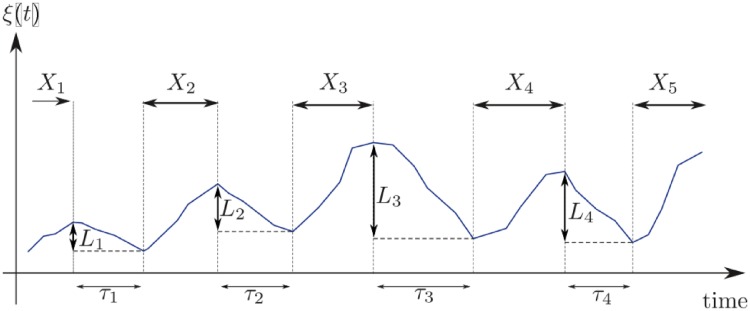
Phases of the business cycle.Trajectory of a representative macroeconomic variable ξ(t) during expansion and recession episodes.